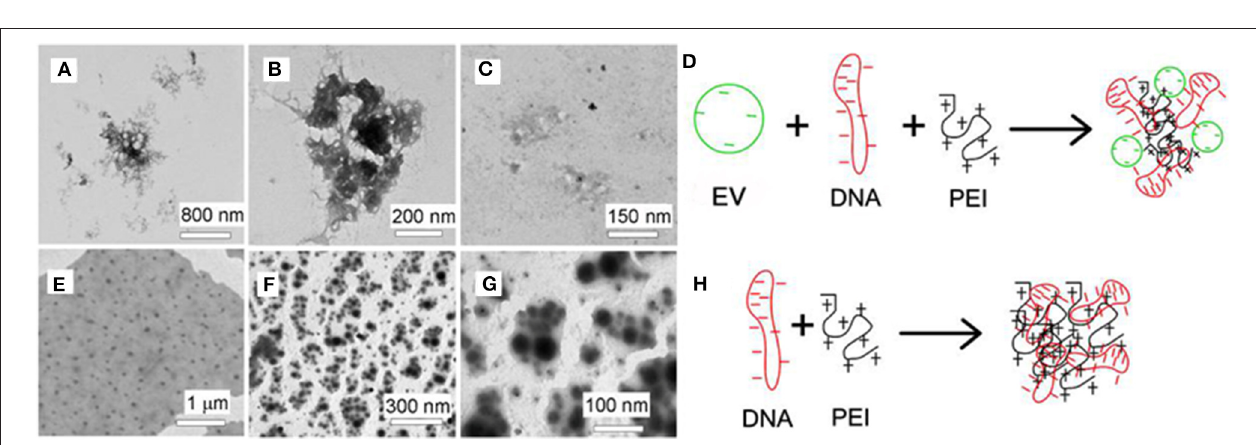
FIGURE 3 | (A–C) TEM images of PEI 25kD /DNA/EVs; (E–G) TEM images of PEI 25kD /DNA; (D,H) Schematic representation of the complex formation of (D) EVs/DNA/PEI and (H) PEI/DNA.